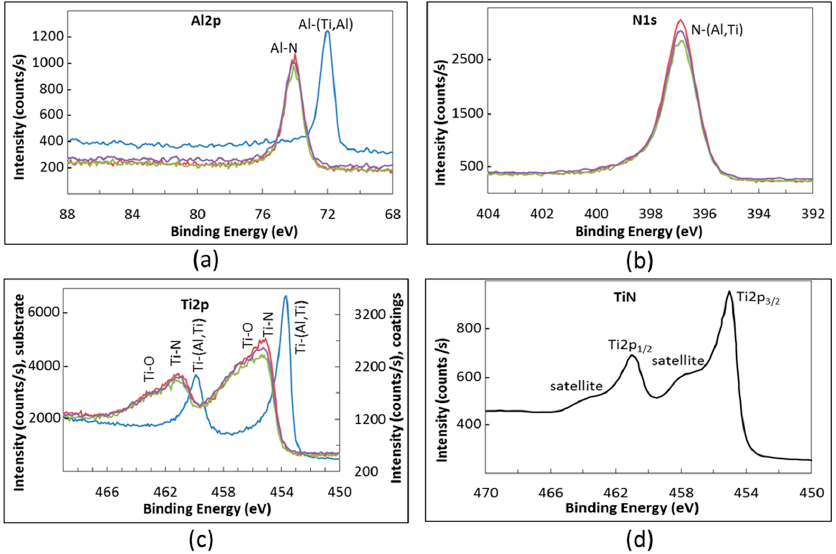
Figure 5. ( a – c ) XPS High resolution spectra of substrate and as-deposited TiAlN films: blue = uncoated intermetallic; red = TiAlN1; green = TiAlN2; and purple = TiAlN3; and ( d ) HR Ti pattern of pure TiN.